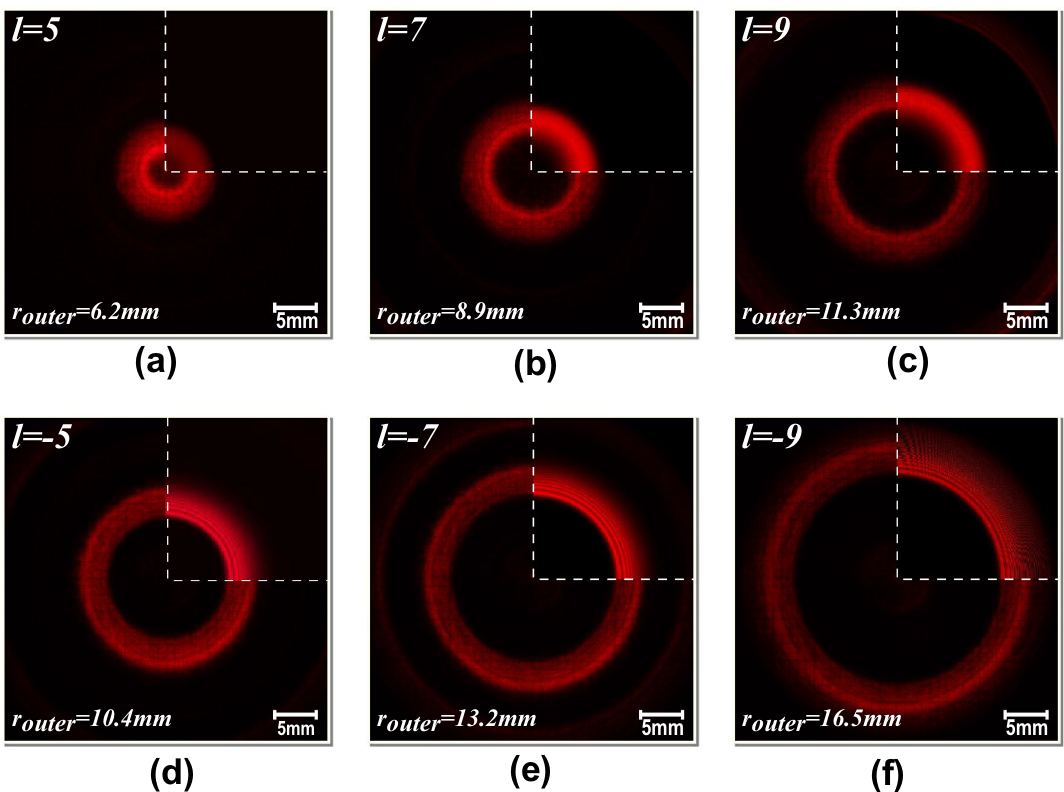
Figure 6. Experimental results of the DSA together with the corresponding simulations (top-right corner in the dashed lines). ( a ) Convergent configuration with l = 5. ( b ) Convergent configuration with l = 7. ( c ) Convergent configuration with l = 9. ( d ) Divergent configuration with l = − 5. (e) Divergent configuration with l = − 7. ( f ) Divergent configuration with l = − 9. The diffraction patterns are projected onto a millimeter and opaque screen at 150 cm from the DSA. The acquisition camera is focused onto the screen. The topological charge and the resulting outer ring radius are indicated in each image.